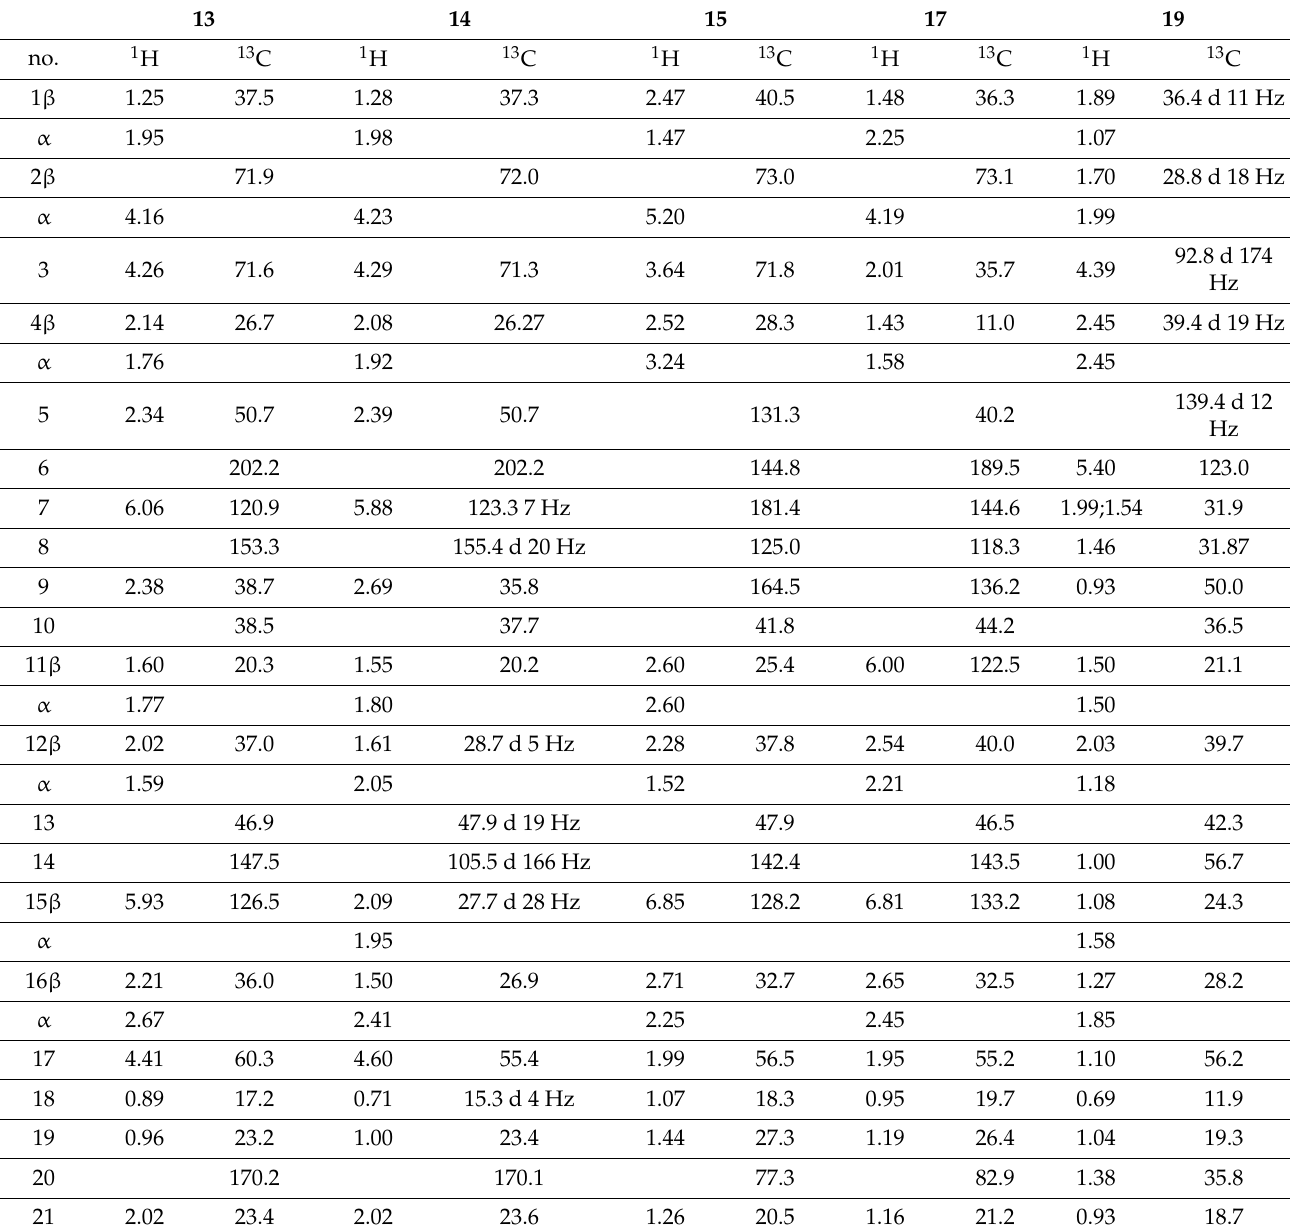
(Figure S3); edHSQC (Figure S4); and HMBC (Figure S5) spectra were utilized. SelNOESY experiments on H 3 -18 and H 3 -19 (Figure S2) unambiguously differentiated H-11 and H-12 signals; furthermore, the 0.62/41.0 ppm H 3 -19/C-12 HMBC cross-peak (Figure S5) con- firmed the ∆ 11,12 position of the new double bond. The chemical shifts of all other 1 H and 13 C NMR signals in compound 4 are similar to that of 3 . Table 2. 1 H and 13 C chemical shifts and J C,F coupling constants of compounds 13 , 14 , and 17 in CDCl 3 ; 15 in CD 3 OD; and 19 in DMSO-d 6